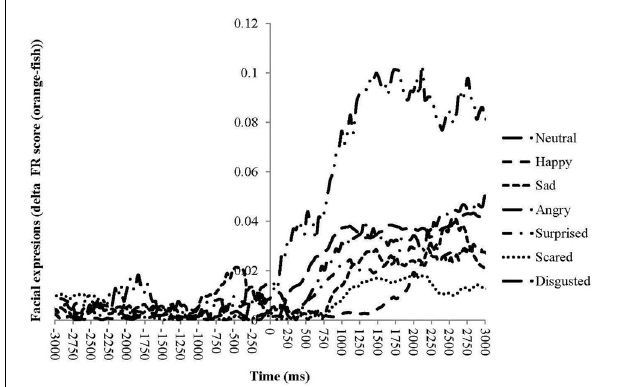
FIGURE 4 | Sequential unfolding of differences in facial expressions between the unpleasant fish odor and the pleasant orange odors for seven emotional facial expressions over time following the odor